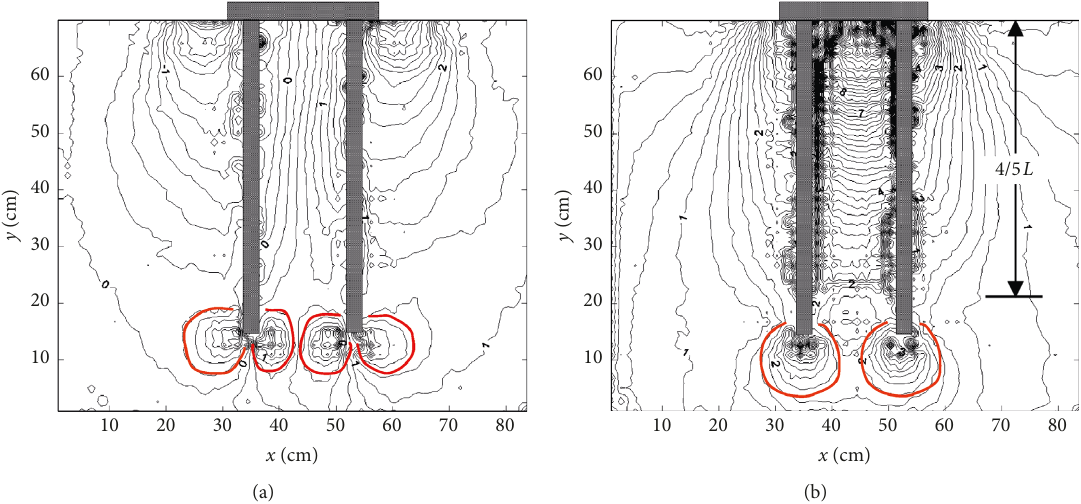
Figure 9: Displacement contour of the pile group with 6 b pile spacing. (a) Horizontal displacement. (b) Vertical displacement.